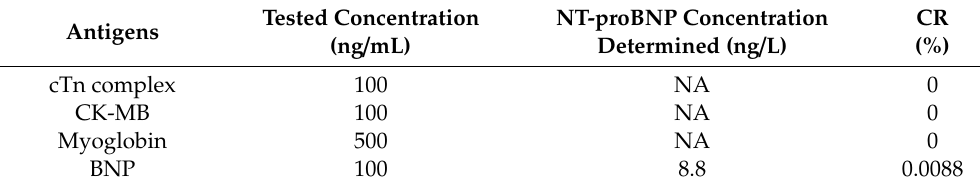
Table 2. Cross-reactivity of MPs-CLEIA with other cardiac biomarkers. Antigens